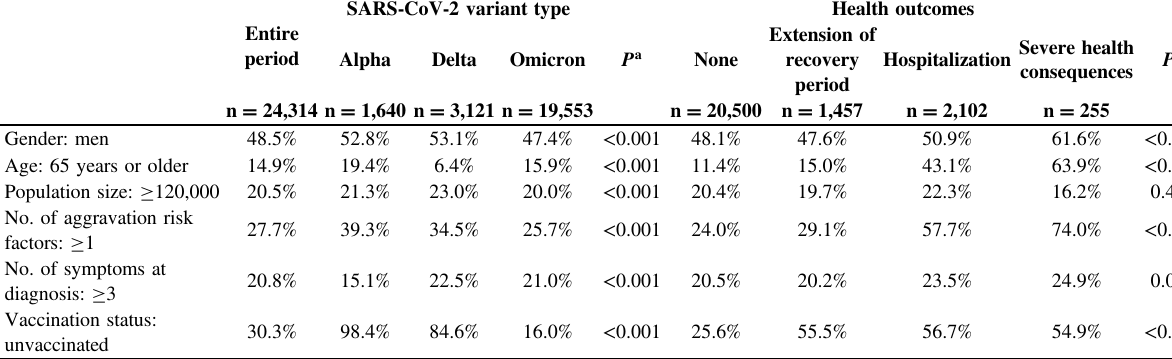
Table 1 Characteristics of the study participants by SARS-CoV-2 variant type or by health outcomes